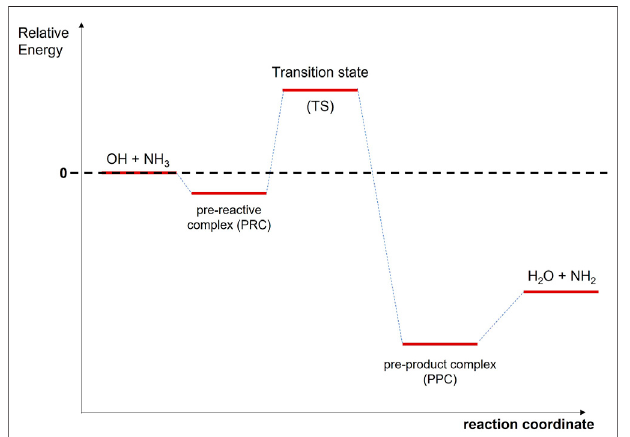
SCHEME 2 | Simpli fi ed reaction energy pro fi le along the MEP for the OH + CH 3 NH 2